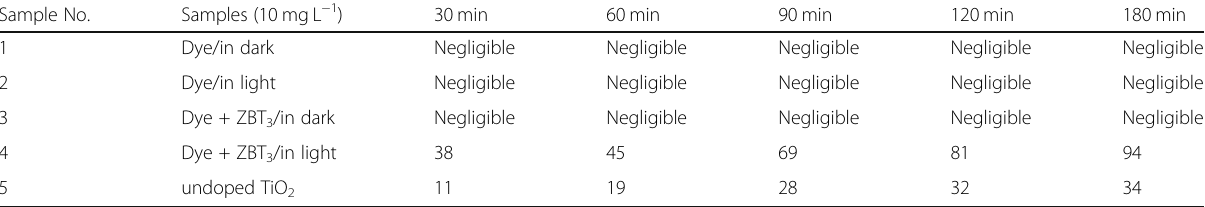
Table 3 Results of the percentage (%) of degradation of dye, dye with nanocatalyst sample Sample